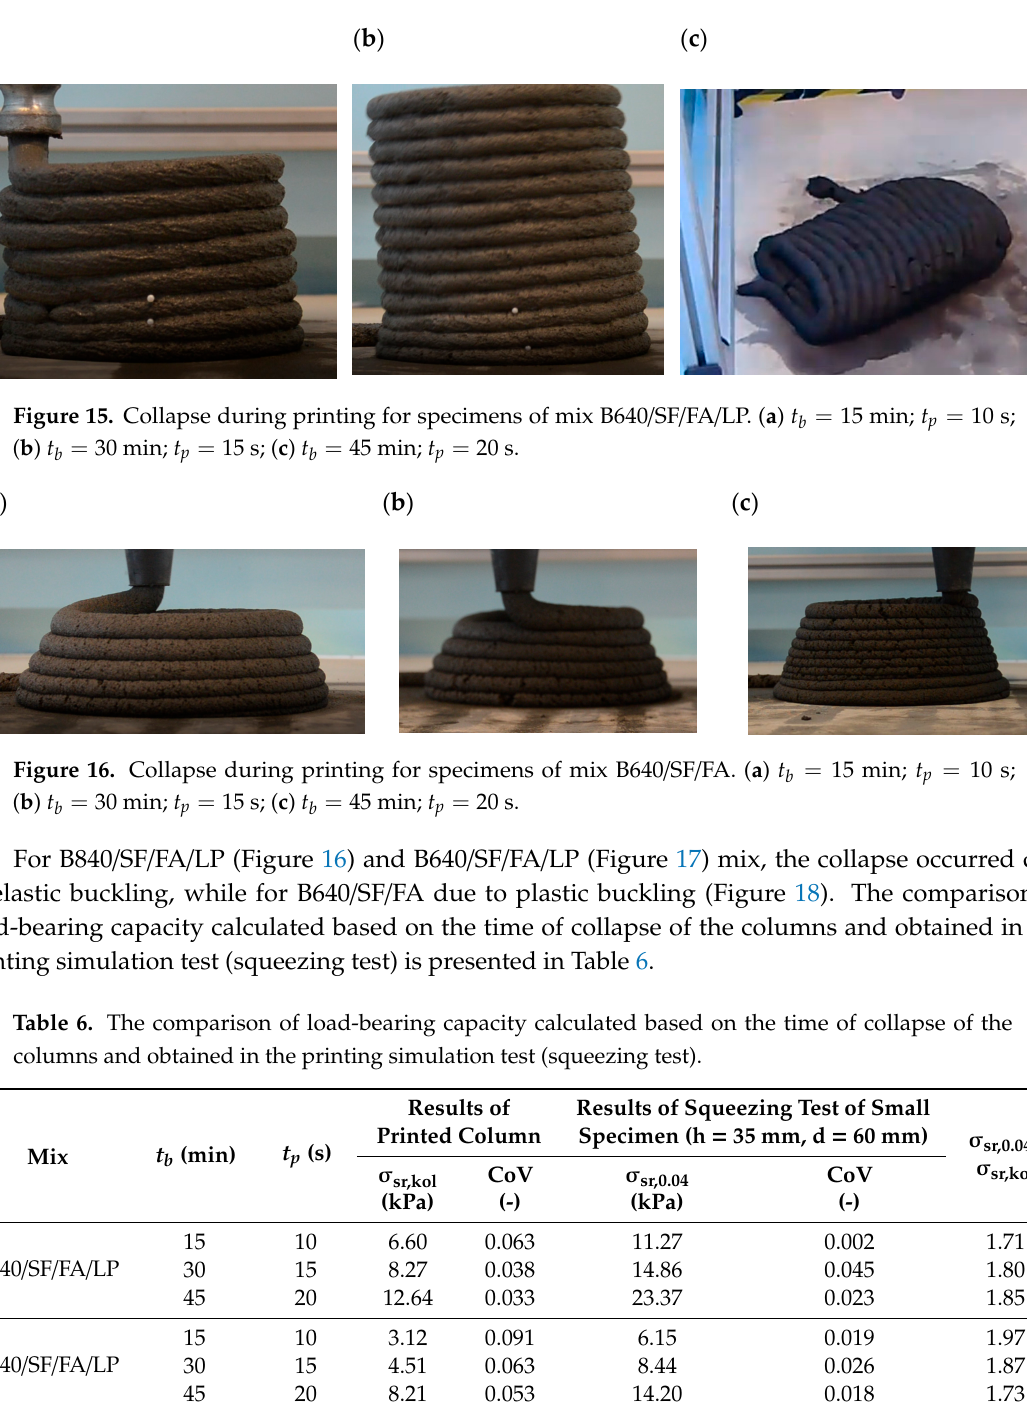
Figure 14. Collapse during printing for specimens of mix B840/SF/FA/LP. ( a ) 𝑡 (cid:3029) = 15 min ; 𝑡 (cid:3043) = 10 𝑠 ; ( b ). 𝑡 (cid:3029) = 30 min ; 𝑡 (cid:3043) = 15 𝑠 ; ( c ) 𝑡 (cid:3029) = 45 min ; 𝑡 (cid:3043) = 20 𝑠